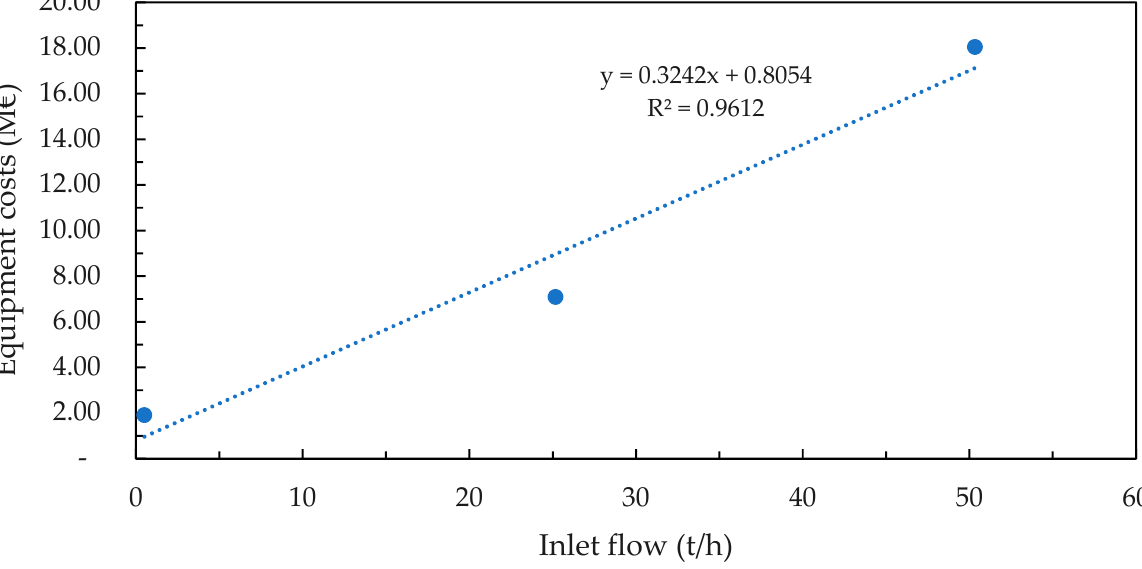
Figure A2. PSA train equipment costs (including PSA and vacuum pump + compression of upgraded SynFeed to 22.2 bar).